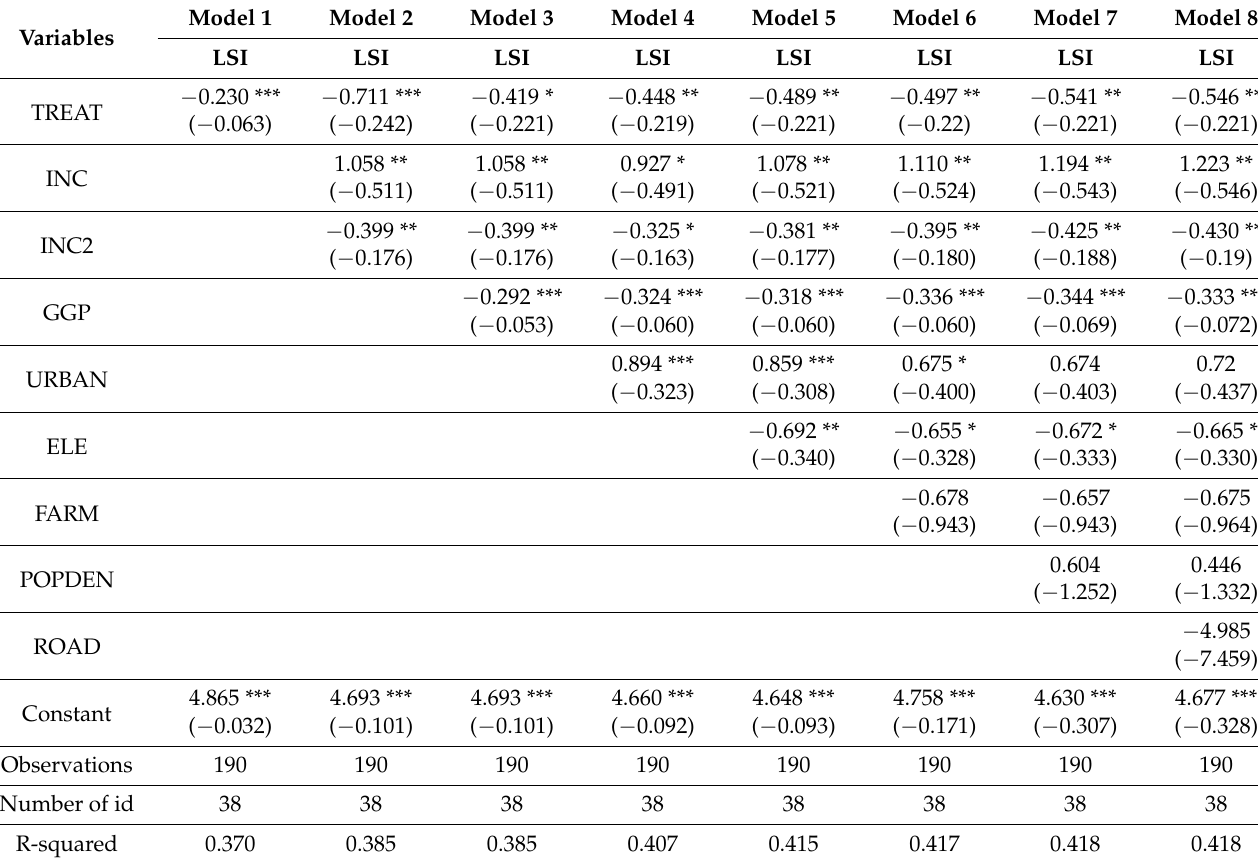
Table 4. Regression results of the benchmark